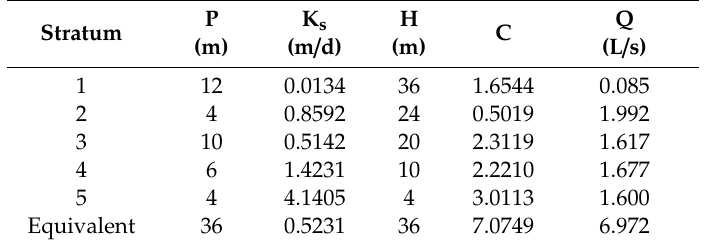
Table 2. Calculation of the flow per stratum corresponding to a full well, Equations (47) and (49).